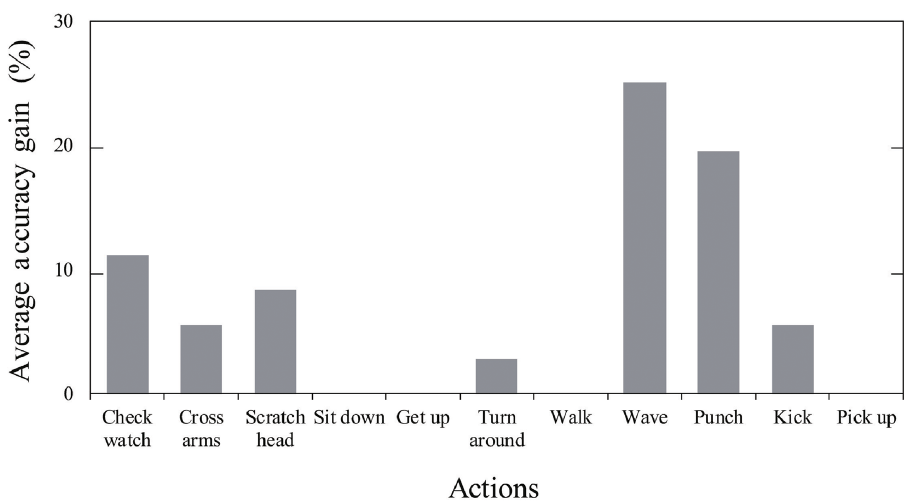
Fig 7. Improvement of recognition rate with the new configuration. There was no improvement in recognizing the- “sit down/get up/pick up”-actions, as perfect recognition rate was achieved by the model with the previous structure. The highest accuracy gain was in recognizing wave action (25%).